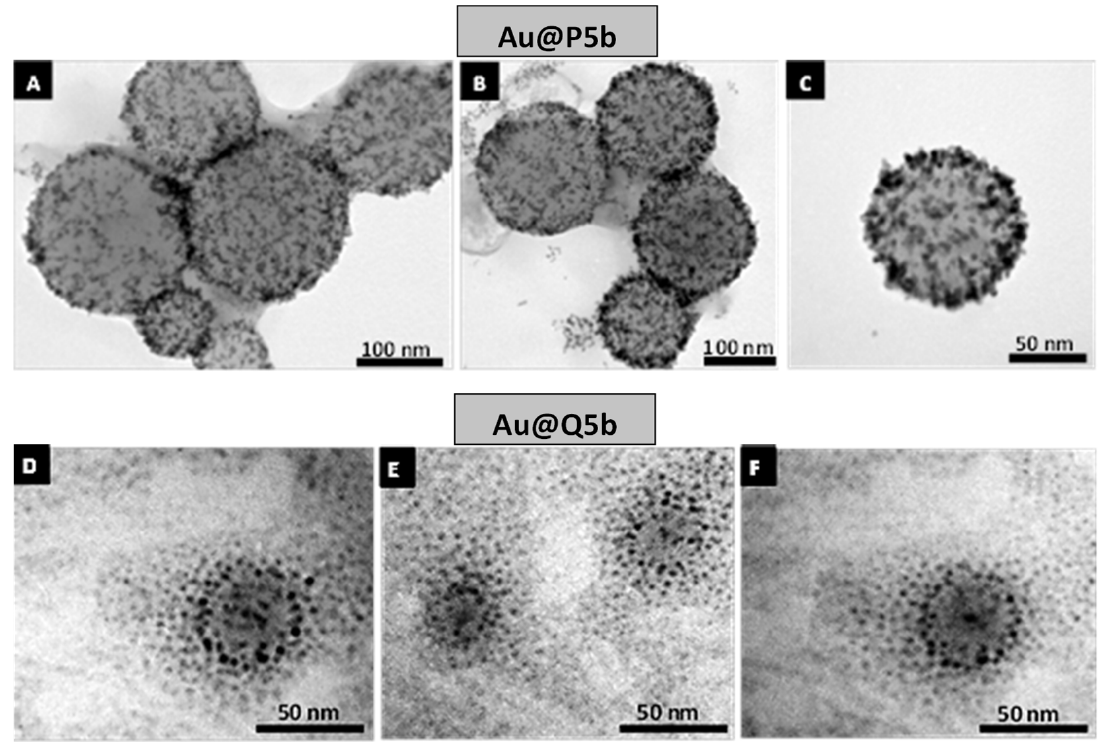
Figure 2. TEM images of gold nanoparticles coated with P5b ( A – C ) and Q5b ( D – F ) in PBS at pH 7.4. The quaternized pentablock terpolymer exists as spherical micelles at pH 7.4 with 2VP q moieties mostly present at the outer corona, while some are caged within the hydrophobic P2VP/PCL core. Metal binding is due to electrostatic attraction and hydrogen bonding of protonated 2VP units with AuCl 4 − . When the ions of AuCl 4 − are added into the polymer solution, they first coordinate with nitrogen atoms of the P(2VP-co-2VP q ) block of the terpolymer and then are reduced into gold nanoparticles. Moreover, the strong polyelectrolyte nature of 2VP q moieties would result in intimate association of the AuCl 4 − counterions prior to the in situ reduction to zero-valent gold [43]. This should ensure efficient adsorption of the polymer chains onto the gold surface. Figure 2D–F show the TEM image of the resultant gold nanoparticles. The average diameter of the Au@Q5b nanoparticles is about 90 nm, as measured from the TEM micrographs, exhibiting a thin dark ring outside the gray core. These must be the AuNPs, located within the 2VP q shell and still surrounded by the PEO corona. They are densely located within the 2VP q shell and are less packed with growing distance. The gold nanoparticles are present at the outer layer of the micelles, and some are visible in the inner micellar compartment. This could be due to selective reduction of the gold ions mainly at the micelle surface, where the 2VP q would be located. After reduction, gold nanoparticles are formed at the PEO/P2VP interface and retain their swelled structure. We had assumed in a previous study that the quaternized pentablock terpolymer micelles formed at physiological pH are spherical micelles composed of PCL/P2VP core caging 2VP q cationic moieties [37]. Herein, the distribution of gold nanoparticles into the inner core and the outer corona confirms this hypothesis. This surprising difference in the deposition of gold nanoparticles in the P2VP core for the P5b and inner/outer compartments for Q5b is likely due to different packing in the as-prepared micelles filled with HAuCl 4 . One can assume that, in the former case, the P2VP chains are very densely packed within the micelle core, obstructing diffusion of the ions, thus leading to the formation of gold@core-corona type nanoparticles. In the case of the quaternized pentablock terpolymer, the micellar hydrophobic compartments are